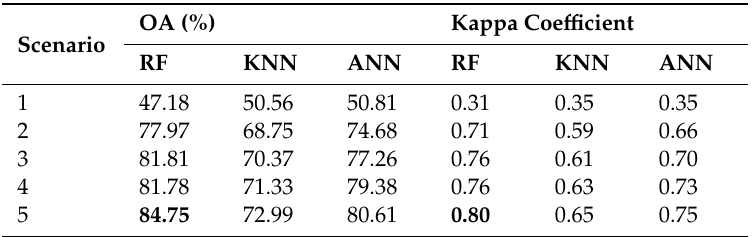
Table 2. Classification accuracies regarding five scenarios with di ff erent classifiers (note: the best overall accuracy (OA) and Kappa Coe ffi cient are shown in bold ). RF: random forest; KNN: k-nearest neighbor; ANN: artificial neural network.